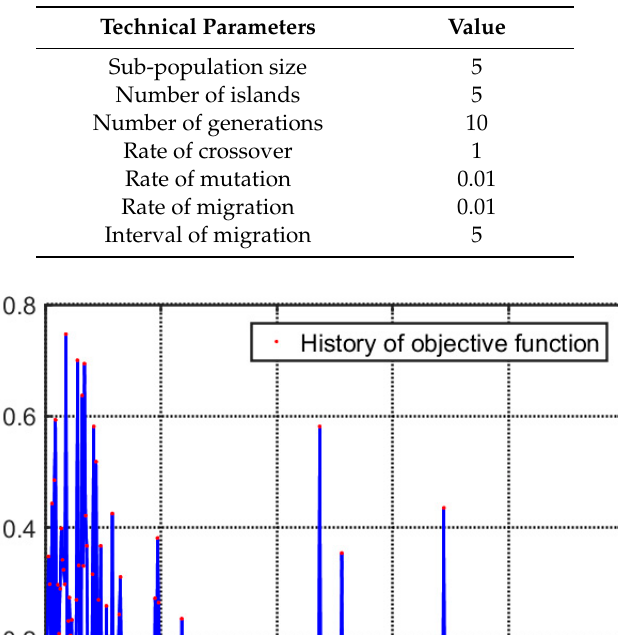
Table 5. Parameter settings in the MIGA.